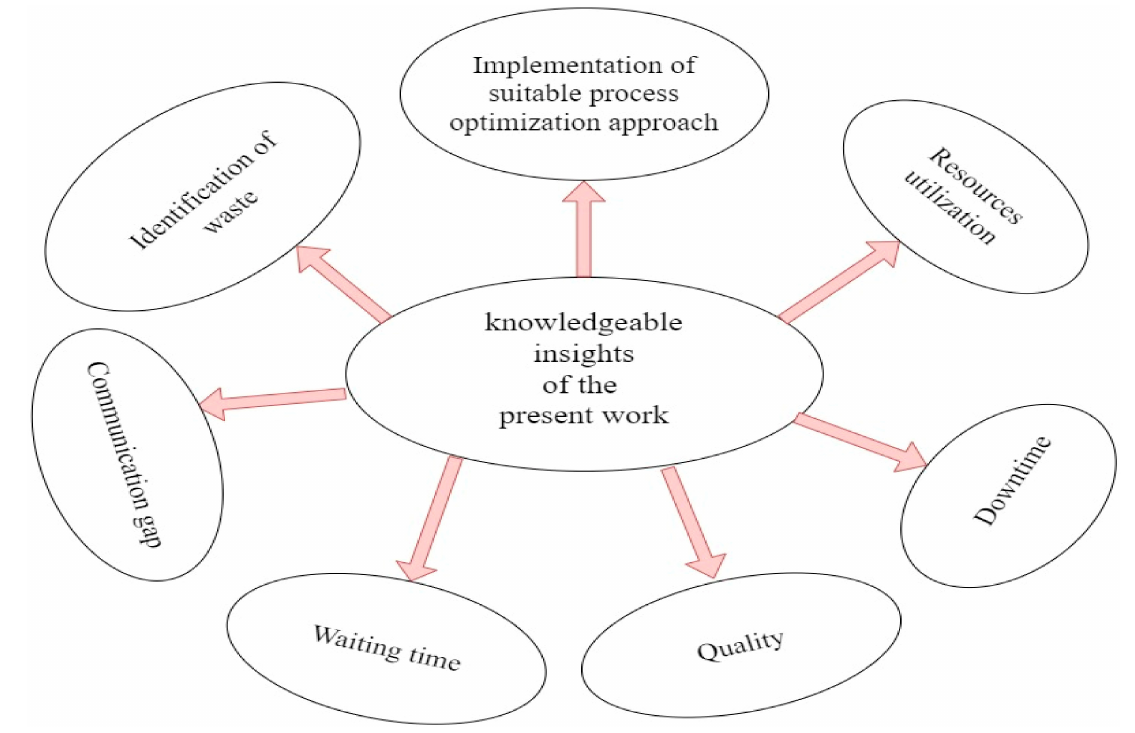
Figure 13. Valuable insights from the shop floor management.